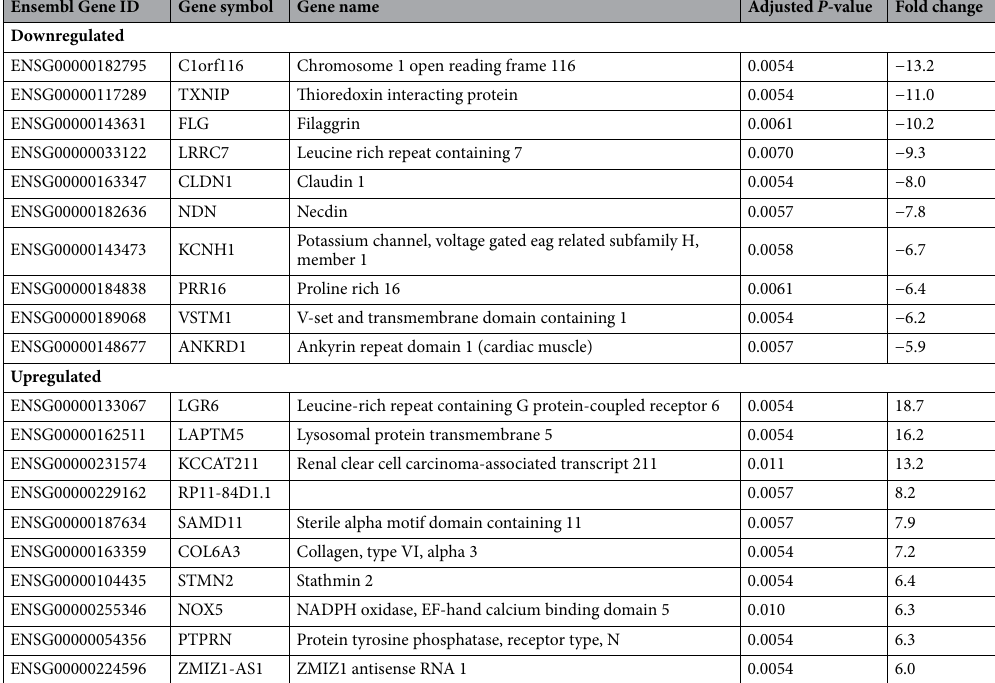
Table 2. Top 10 significantly downregulated (upper part) and upregulated (lower part) genes upon TXNIP knockdown in A375 cells, as measured by